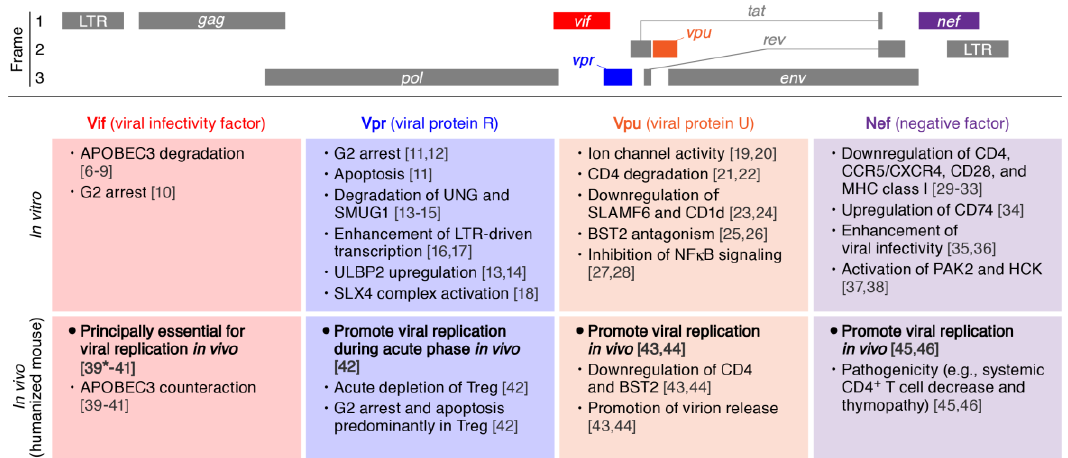
Figure 1. Roles of Human immunodeficiency virus type 1 (HIV-1) accessory proteins in vitro and in vivo . (Top) The scheme of HIV-1 genome. Three reading frames are respectively indicated. (Middle) Major roles of HIV-1 accessory proteins reported from the experiments using cell cultures. (Bottom) The roles of HIV-1 accessory proteins elucidated from the experiments using humanized mouse models. The numbers in parentheses indicate the references. *, as an exception; Vif is dispensable if a vif- deficient CXCR4-tropic HIV-1 (strain LAI) is intravenously inoculated into BLT humanized mice [39]. APOBEC3, apolipoprotein B mRNA editing enzyme, catalytic polypeptide-like 3; UNG, Uracil-DNA glycosylase; SMUG1, single-strand-selective monofunctional uracil-DNA glycosylase 1; LTR, long terminal repeat; ULBP2, UL16 binding protein 2; SLX4, SLX4 structure-specific endonuclease subunit; BST2, bone marrow stromal cell antigen 2; SLAMF6, signaling lymphocyte activation molecule family member 6; PAK2, p21 protein (Cdc42/Rac)-activated kinase 2; HCK, hematopoietic cell